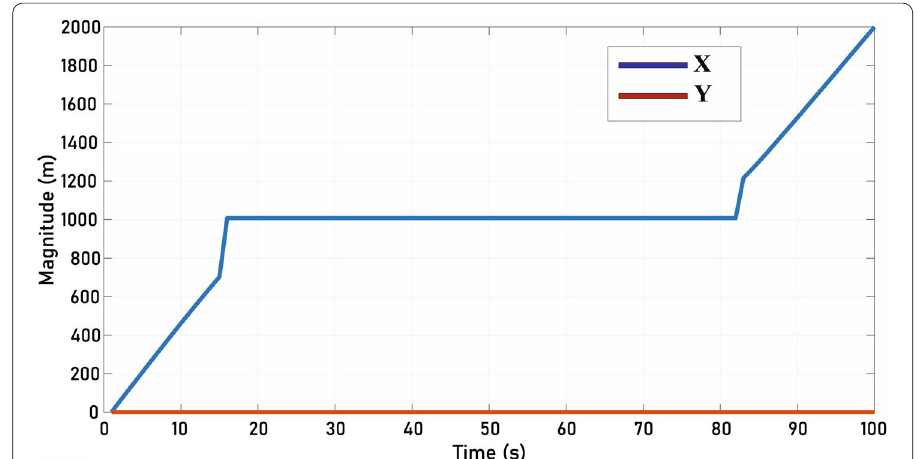
Fig. 7 X - and Y -axis of optimized trajectory with fixed power allocation